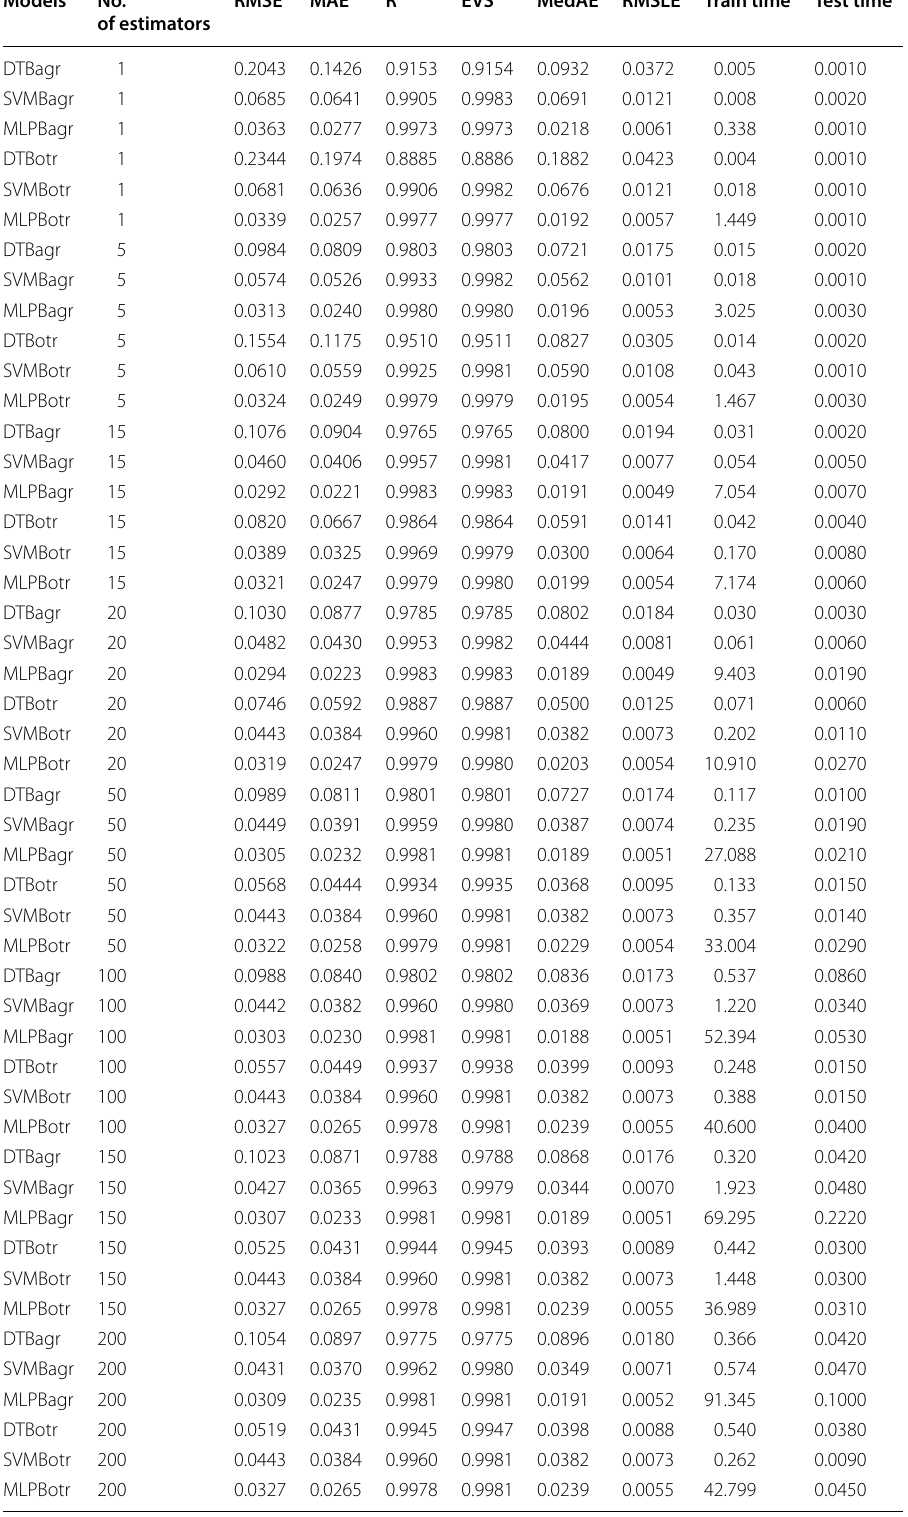
Table 14 Bagging and boosting ensemble regressors error metrics result over JSE dataset